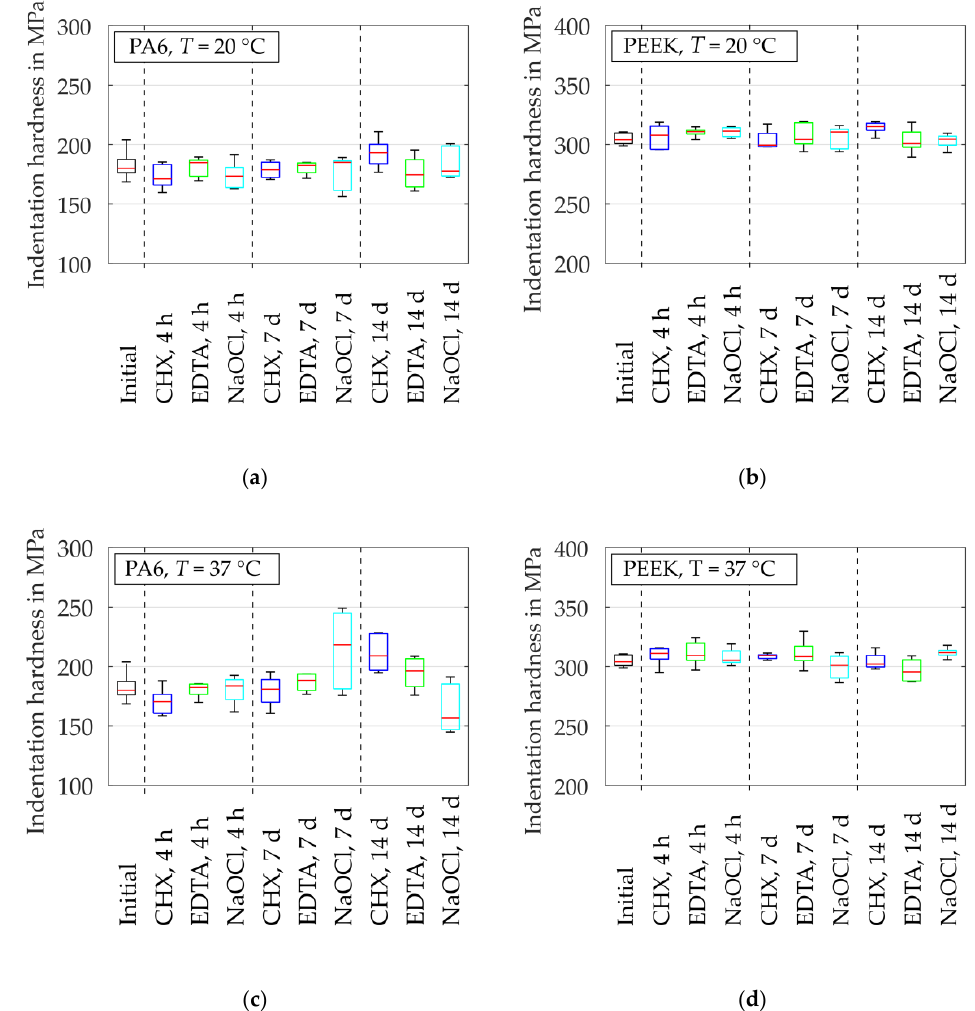
Figure 5. Alteration of material indentation hardness H IT (dried samples) after different storage times: ( a ) PA6 at T = 20 ◦ C; ( b ) PEEK at T = 20 ◦ C; ( c ) PA6 at T = 37 ◦ C and ultrasonic excitation; ( d ) PEEK at T = 37 ◦ C and ultrasonic excitation.